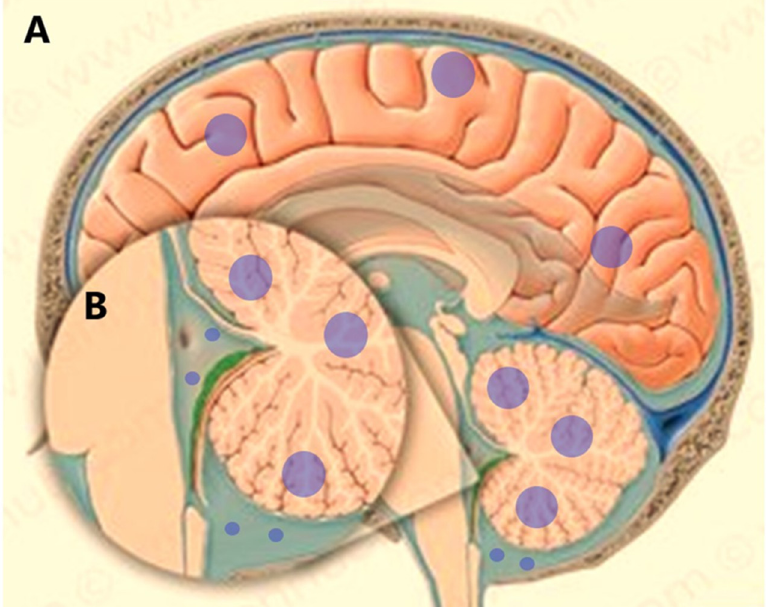
Figure 4. Leptomeningeal dissemination from brain tumors. ( A ). Brain lesions are shown with blue circles. ( B ). Tumor cell dissemination into the CSF